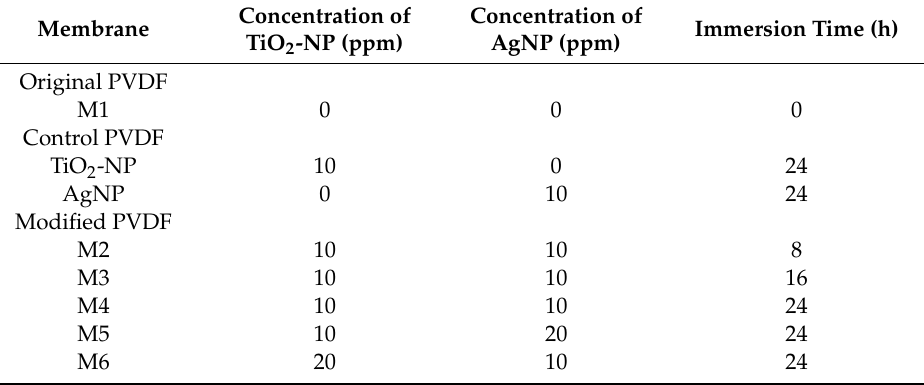
Figure 1. Schematic diagram for TiO 2 -NP / AgNP dipped coating of 75 cm 2 of flat sheet PVDF membrane into 1L solution. Table 3. Concentrations of TiO 2 -NP and AgNP and coating time for membrane modification.